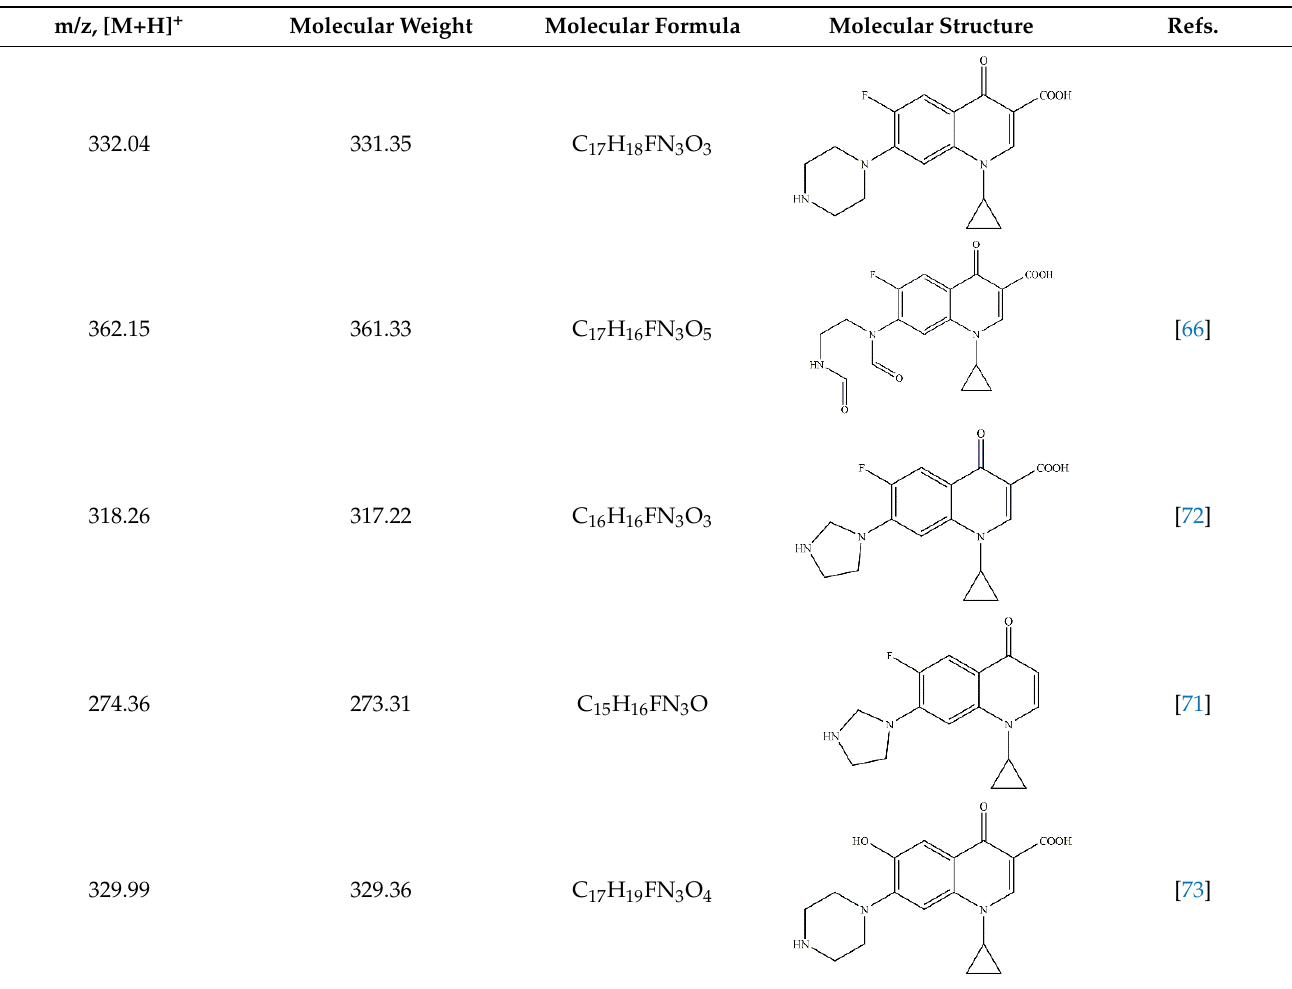
Table 2. Main products of CIP degradation detected by LC-MS.